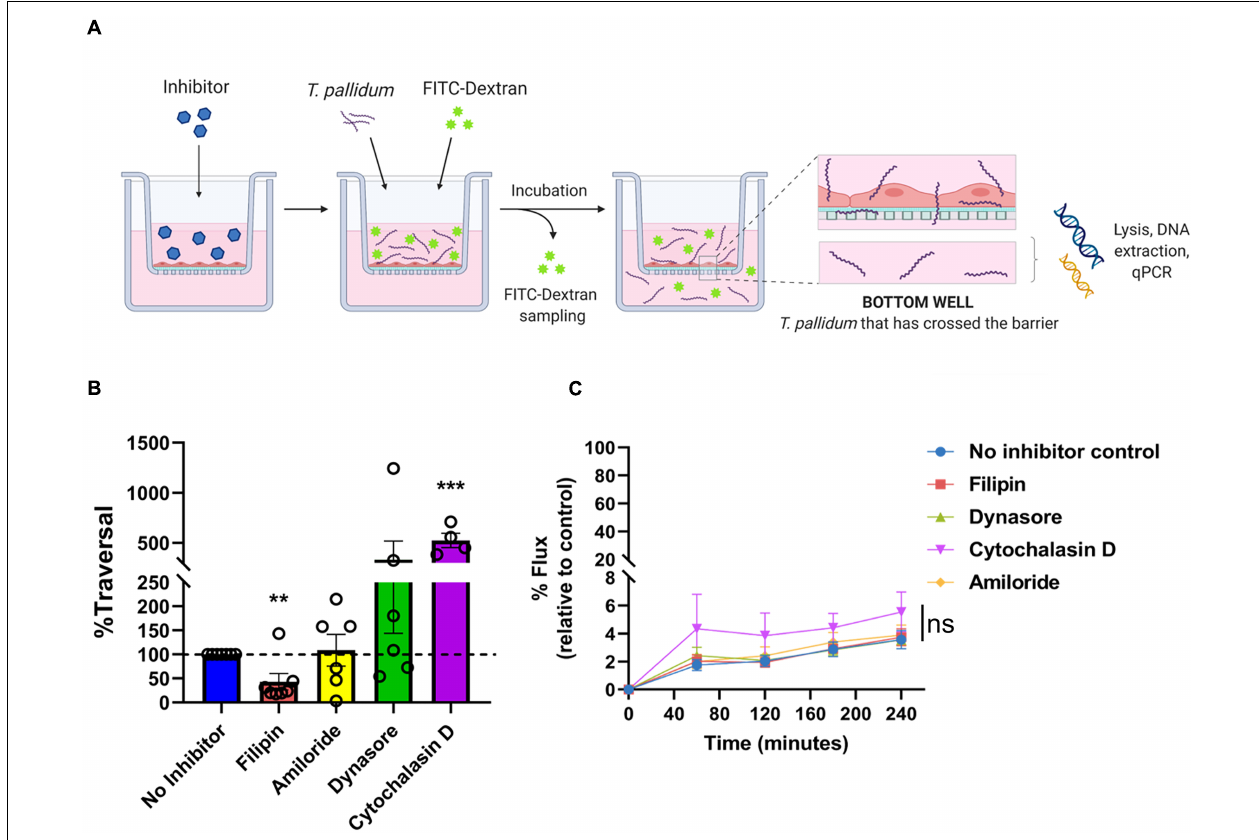
FIGURE 8 | Treponema pallidum traversal of endothelial barriers is partially abrogated with an inhibitor of lipid raft-mediated endocytosis. (A) Schematic of transendothelial migration assay. Prior to experimentation, barrier integrity was confirmed using transendothelial electrical resistance (TEER), where monolayer resistance > 12 (cid:127) × cm 2 dictated an intact monolayer. Endothelial monolayers were treated with inhibitors of endocytosis, followed by addition of live T. pallidum. Barrier permeability was assessed with a transwell solute flux assay, where endothelial permeability in the presence T. pallidum was monitored with a FITC-dextran fluorescent tracer by sampling from the bottom compartment of the transwell for fluorescence measurements throughout the time course of the experiments. T. pallidum traversal was evaluated by collecting the media from the lower compartment in each well and quantifying traversal with quantitative polymerase chain reaction (qPCR) detection of endoflagellar sheath gene flaA . Image created with BioRender. (B) T. pallidum traversal across HUVEC monolayers in untreated control (blue) or in the presence of inhibitors against lipid-raft mediated endocytosis (filipin, red), macropinocytosis (amiloride, yellow), dynamin-dependent endocytosis (Dynasore, green), or a positive control for endothelial barrier disruption that disrupts actin polymerization (cytochalasin D, purple). Endocytosis inhibitors were added at concentrations used in previous publications: filipin III at 5 µ M (Rothberg et al., 1990; Schnitzer et al., 1994; Voigt et al., 2014), amiloride at 300 µ M (Zhao et al., 2011; Li et al., 2013) (Sigma-Aldrich), Dynasore at 80 µ M (Basagiannis et al., 2017; Loh et al., 2017), or Cytochalasin D at 0.1 µ M (Wojciak-Stothard et al., 1999). Traversal was assessed using quantitative real-time PCR to measure flaA DNA concentrations in the bottom compartment of transwell plates. Results are presented as mean ± SEM percent T. pallidum traversal relative to the untreated control (set as 100% traversal, dashed red line) and statistical significance was analyzed by one-sample t -test for endocytosis inhibitor treatments; filipin (** p = 0.0157 n = 7); amiloride (ns p = 0.7017 n = 5); Dynasore (ns p = 0.4022 n = 6); cytochalasin D (*** p = 0.00936 n = 4). (C) Solute permeability of HUVEC monolayers exposed to endocytosis inhibitors was evaluated with the fluorescent tracer FITC-dextran in the presence of T. pallidum and inhibitor treatments over 4 h. Results are normalized to transwells containing artificial basement membrane without endothelial cells (set as 100% flux of FITC-dextran) and presented as mean ± SEM. Statistical significance was analyzed by two-way ANOVA comparing no inhibitor control ( n = 7), filipin ( n = 7), amiloride ( n = 5), Dynasore ( n = 6), and cytochalasin D ( n = 4). Comparison between inhibitor treatments ns p = 0.3073; comparison between time points p <